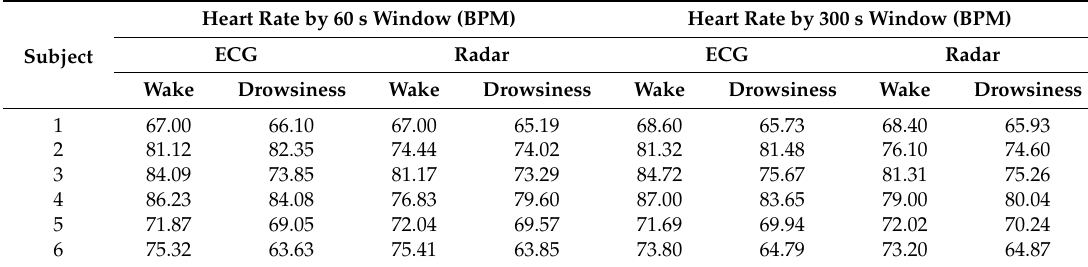
Table 3. The average of the mHR in the wake–drowsiness states obtained from the analysis window.